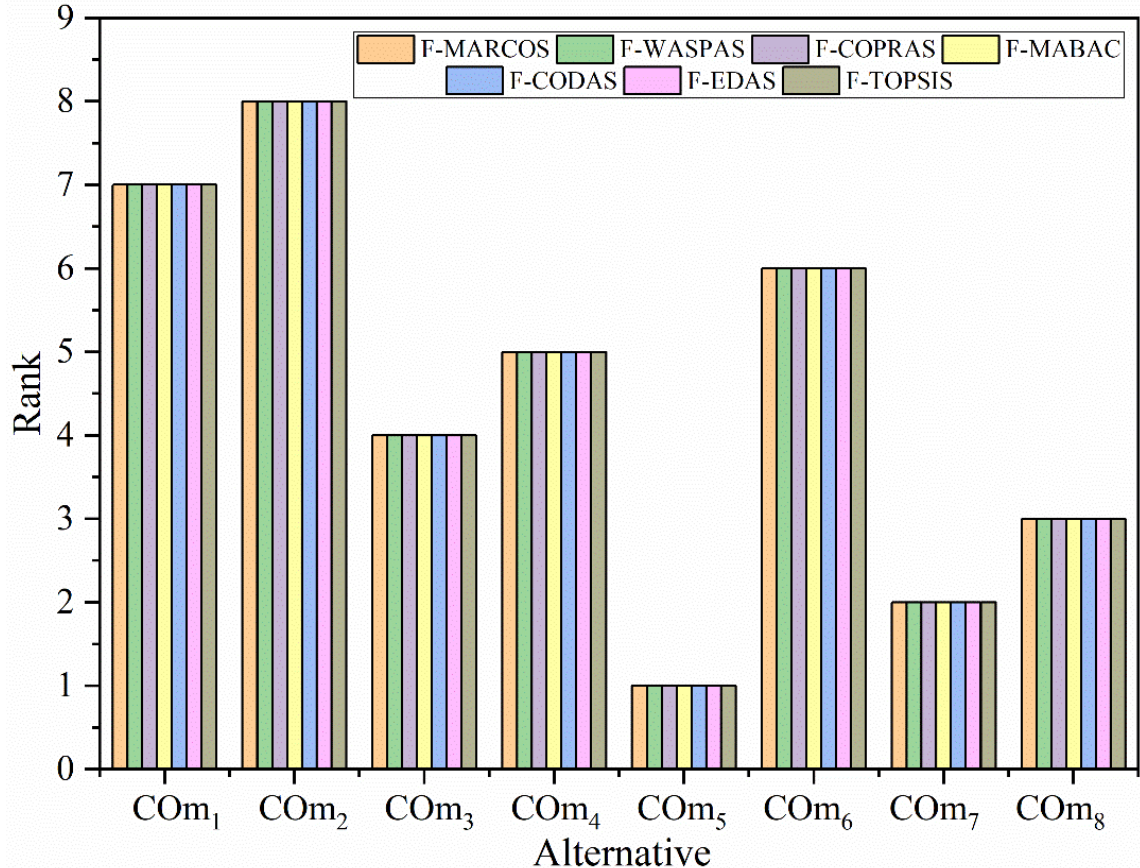
Figure 5. Ranking of alternative using different MADM methods.